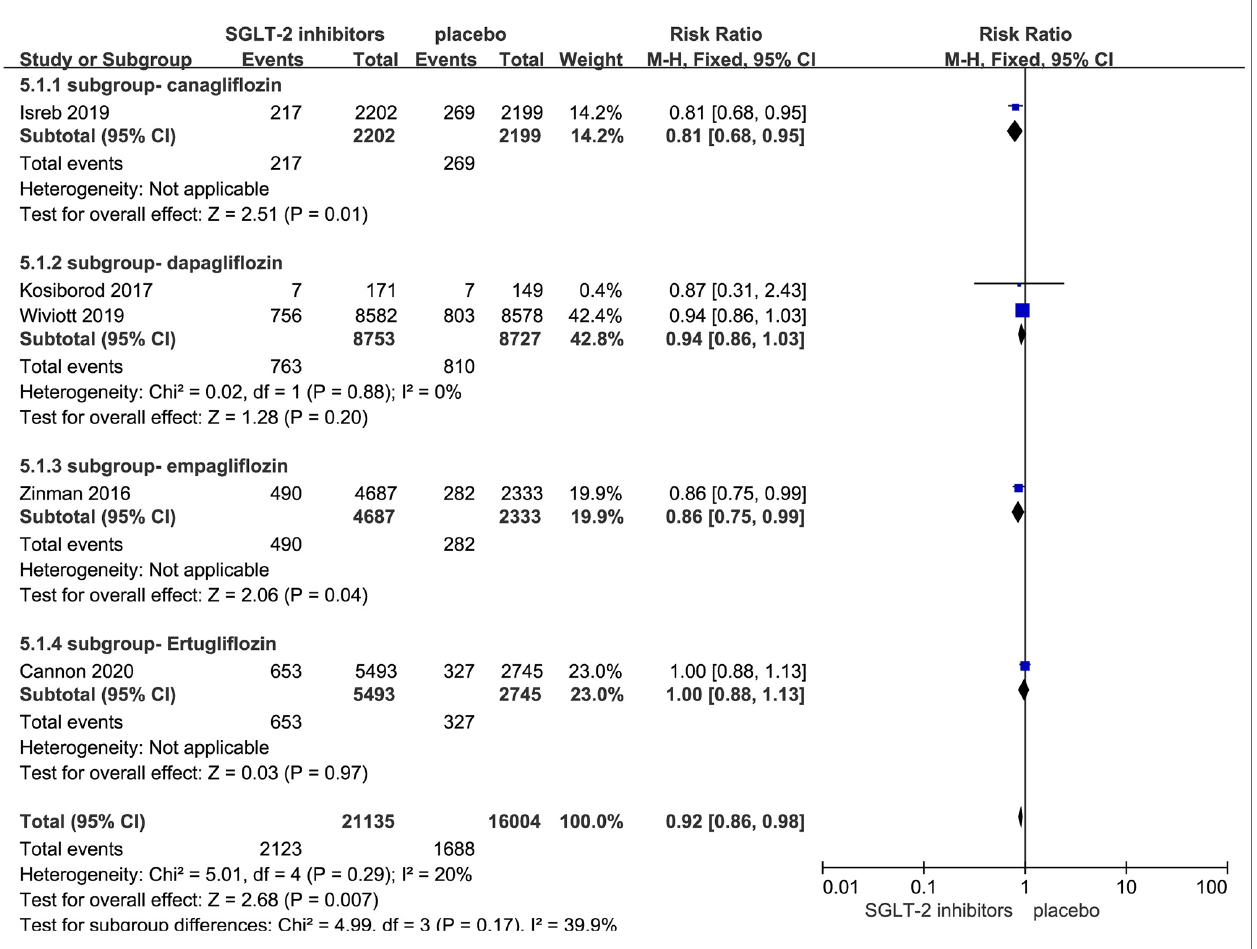
FIGURE 3 | MACE in type 2 diabetes patients receiving SGLT2 inhibitors versus